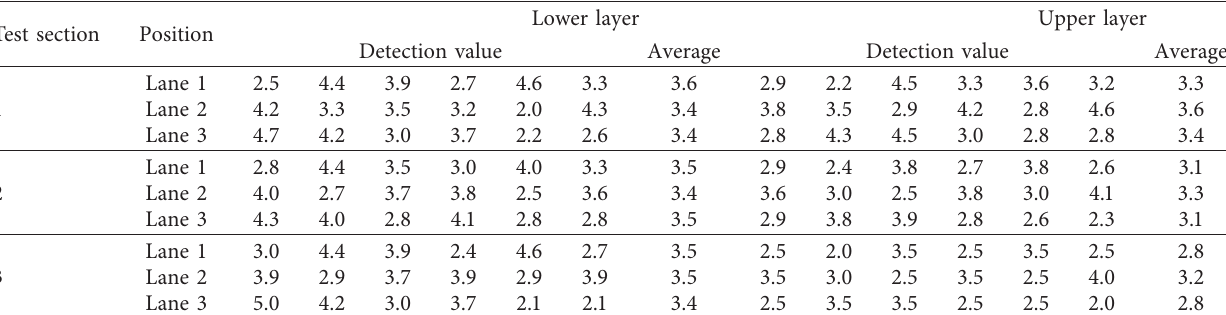
Table 6: Test results of longitudinal evenness